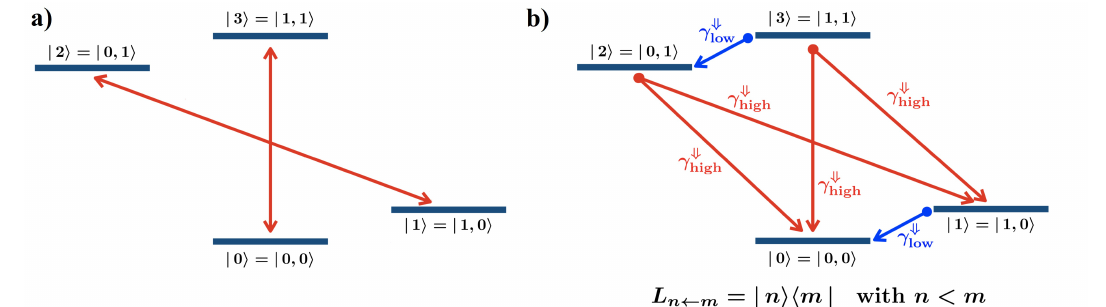
Figure 3: a) Transitions between the energy levels of the unperturbed system in- troduced through the perturbation Hamiltonian in Eq. (18) ; b) Downward jump = | n 〉〈 m | with n < m , which, together with their hermitean con- operators, L n ← m ≡ L jugates, L † , the upward jump operators, define the dissipative Lindblad n → m n ← m dynamics. We distinguish high energy jump operators, in red, from low-energy ones, ⇓ ⇓ in blue. The former have coupling strength γ , while the latter γ high low